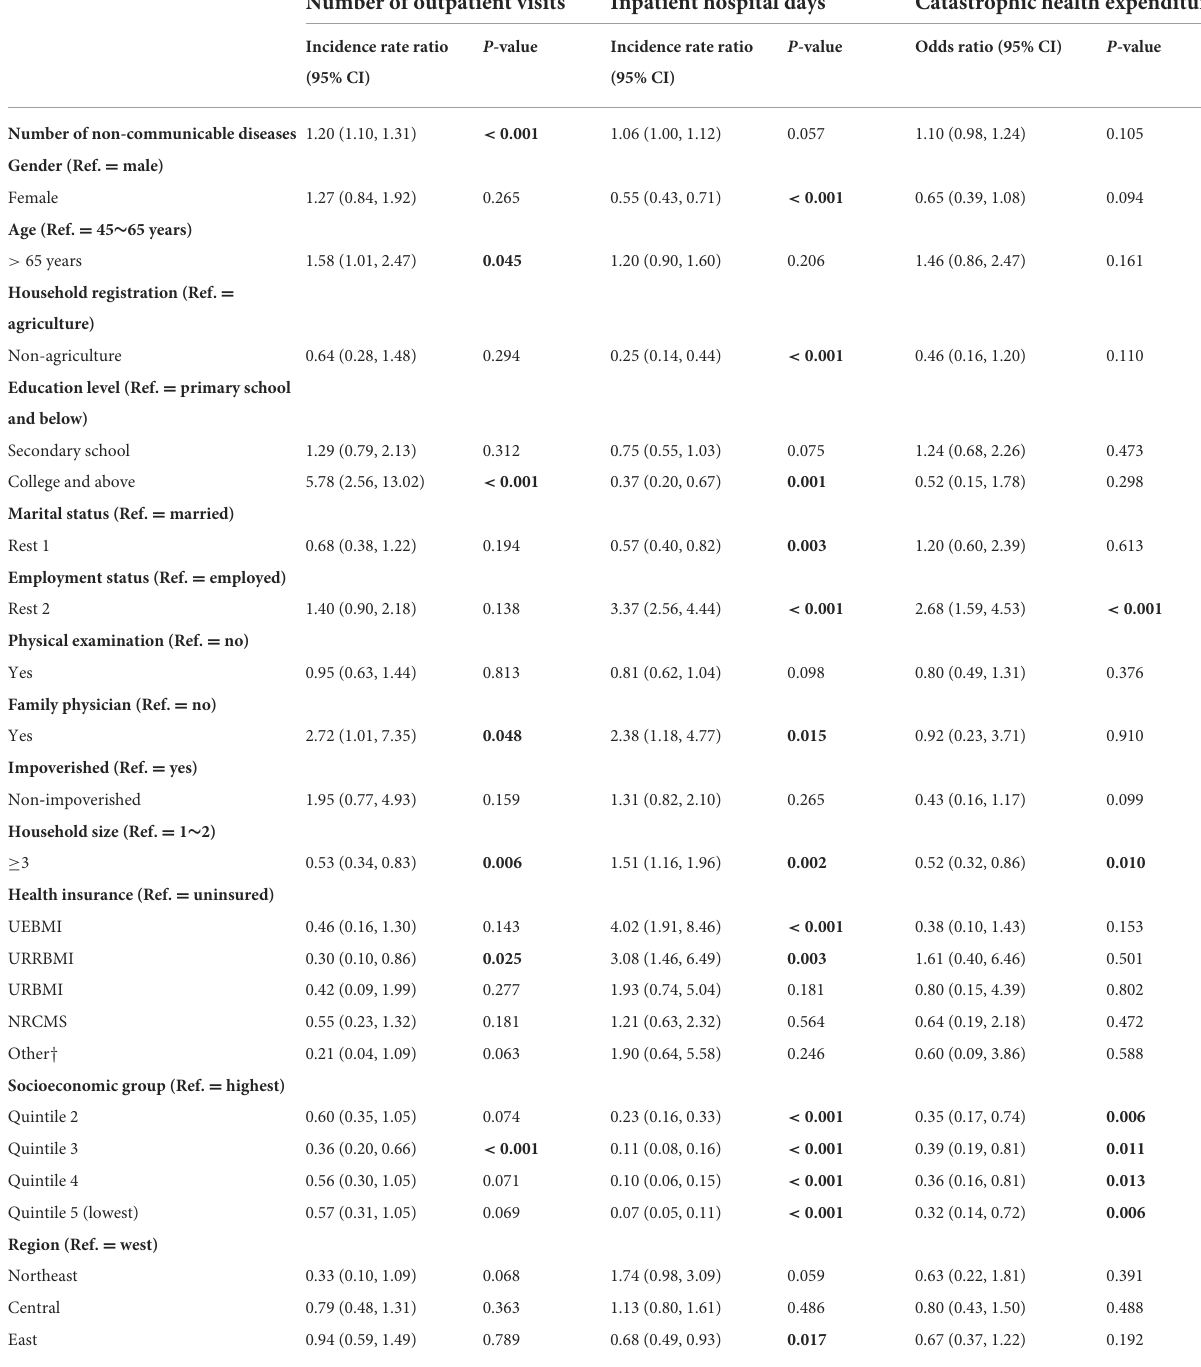
TABLE 3 Factors associated with health care utilization and catastrophic health expenditure among cancer patients in China, 2018. Number of outpatient visits Inpatient hospital days Catastrophic health